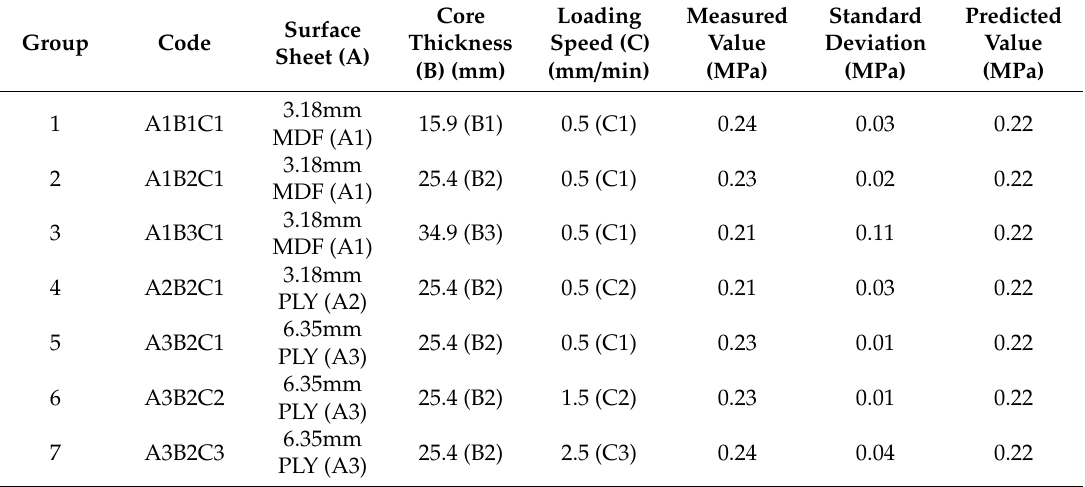
Table 4. Predicted strength derived by the cell wall characteristics and measured results of the sandwich structure under transverse compression.